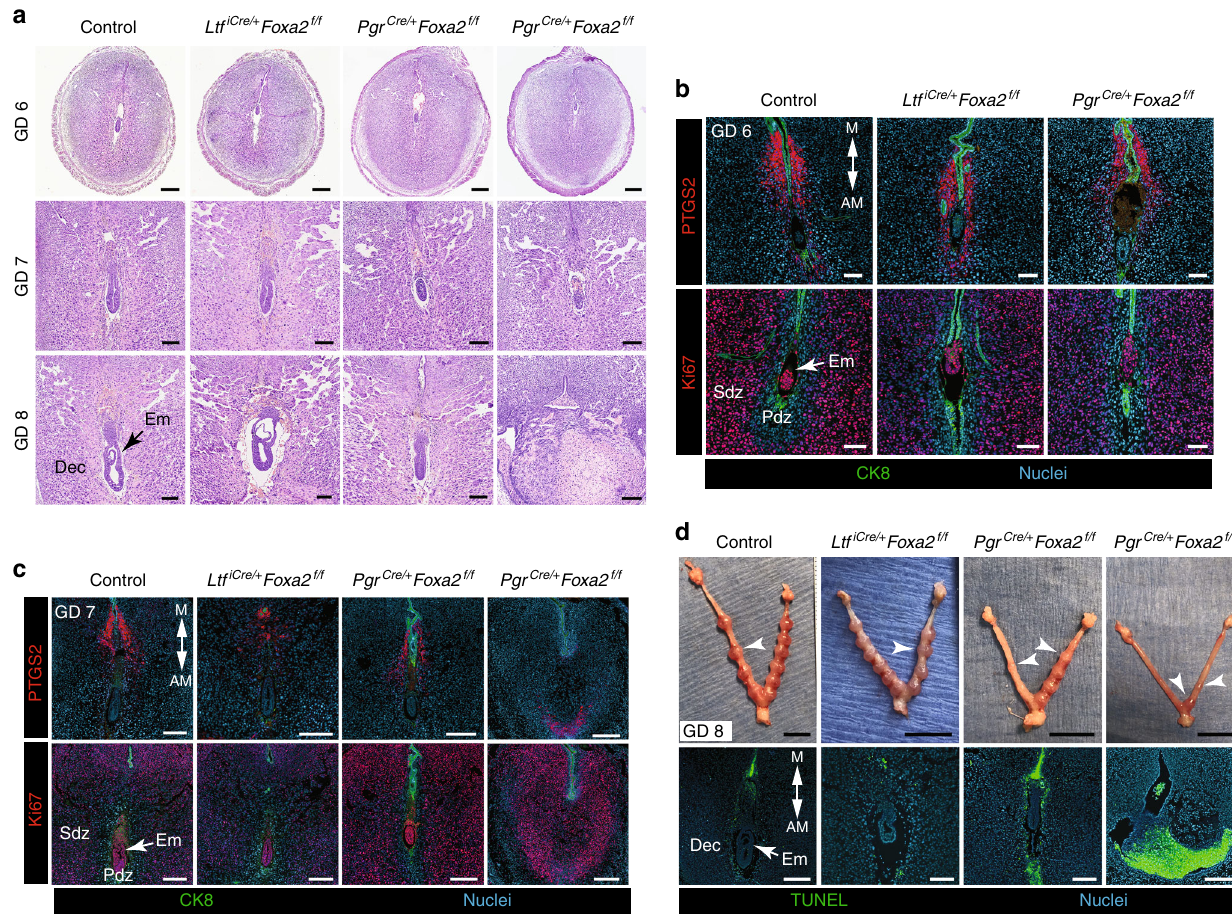
Fig. 5 Uterine glands are essential for decidual progression and pregnancy establishment in mice. Control, gland-containing Ltf iCre/ + Foxa2 f/f and glandless Pgr Cre/ + Foxa2 f/f mice received i.p. injections of recombinant mouse LIF on GD 4 and were evaluated on GDs 6, 7, and 8. a Sections of implantation sites were stained with hematoxylin and eosin. Note the variation in embryo and decidua development on GDs 7 and 8 in the glandless Pgr Cre/ + Foxa2 f/f uterus. Row 1 — Scale bar: 250 μ m; Row 2 — Scale bar: 150 μ m; Row 3 — Scale bar: 150 μ m. b Immuno fl uorescence analysis of PTGS2 and Ki67 (cell proliferation marker) in implantation sites on GD 6. Scale bar: 100 μ m. c Immuno fl uorescence analysis of PTGS2 and Ki67 (cell proliferation marker) in implantation sites on GD 7. Scale bar: 250 μ m. d Gross morphology of the uterus on GD 8 (top panel). White arrowheads indicate individual implantation sites. Scale bar: 1 cm. TUNEL staining to detect apoptosis in implantation sites on GD 8 (bottom panel). Scale bar: 250 μ m. Em: embryo, Dec: decidua, Pdz: primary decidual zone, Sdz: secondary decidual zone. All images are representative of three independent